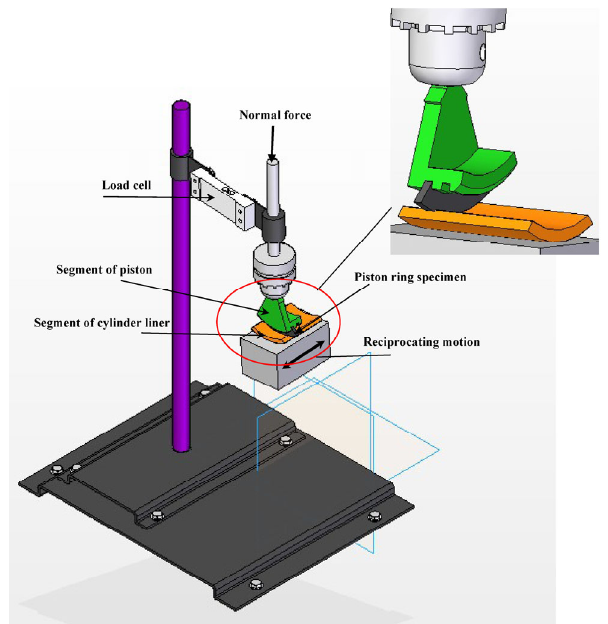
Fig. 1 Schematic illustration of the test rig.